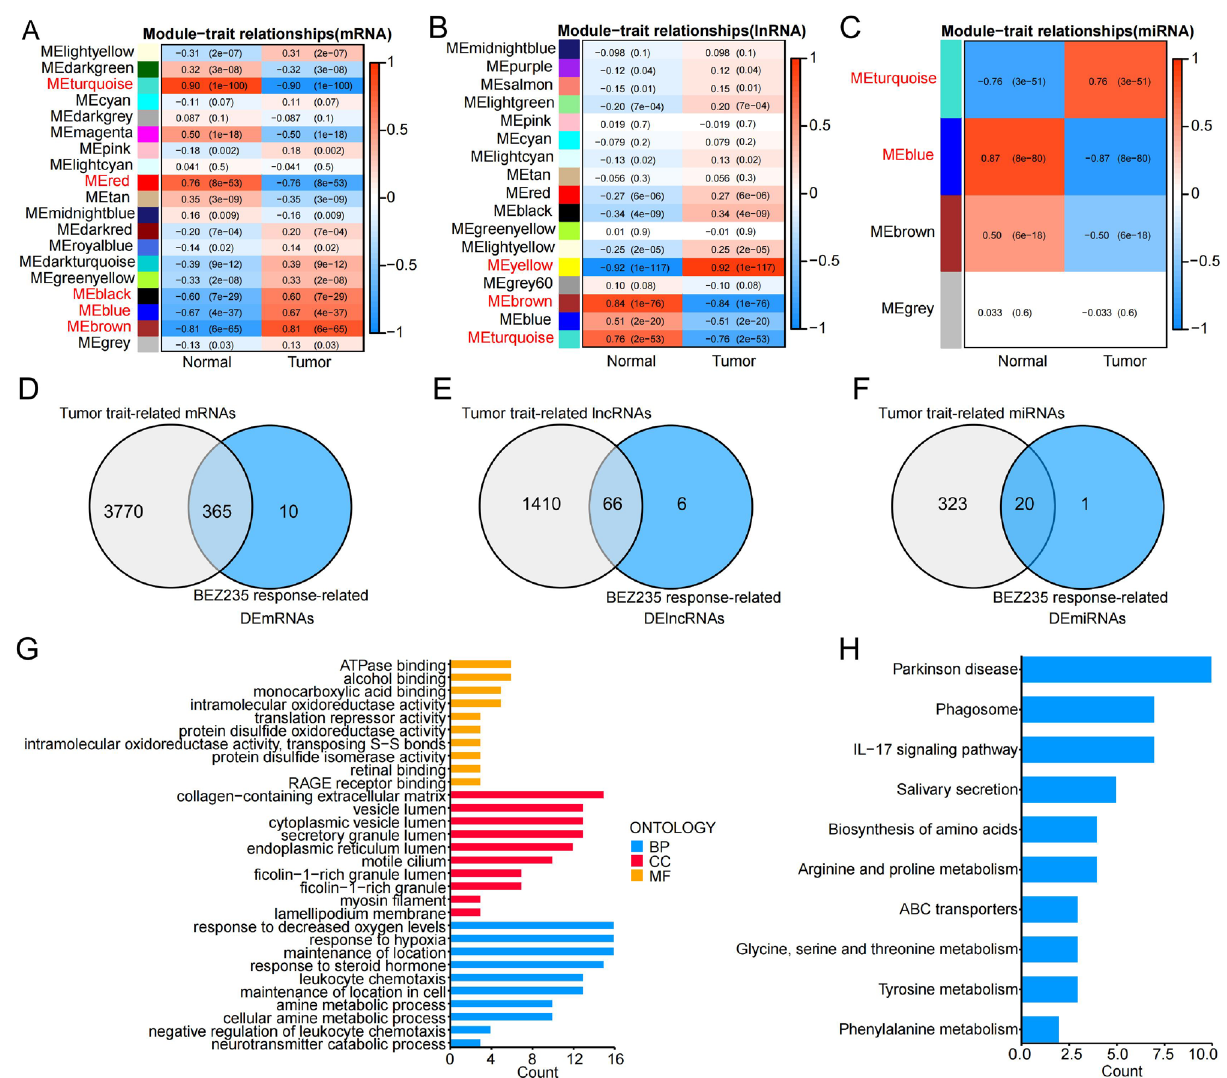
Figure 2. Screening for the BEZ235 response-related genes associated with tumor trait and function analysis. ( A – C ) The correlation of the modules with the tumor traits was shown in the heatmap. Each cell contained the corresponding correlation and P value. The red font represents the selected modules. ( D – F ) The Venn diagram was utilized to obtain tumor-related and BEZ235 response-related DERNAs. ( G – H ) Enrichment of GO and KEGG terms for BEZ235 response-related genes associated tumor trait. DERNAs: differentially expressed